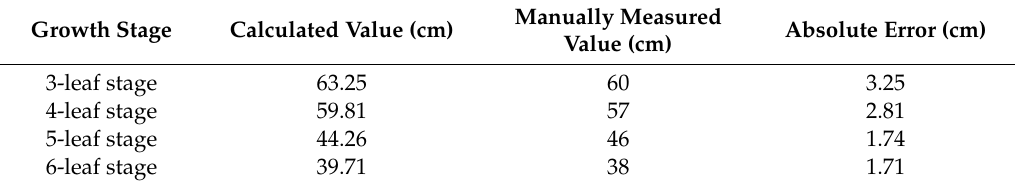
Figure 3. Corn plants at different growth stages: ( a ) 3-leaf stage; ( b ) 4-leaf stage; ( c ) 5-leaf stage; and ( d ) 6-leaf stage. Table 3. Calculated and manually measured values of distance from the sensor to the canopy at different growth stages.